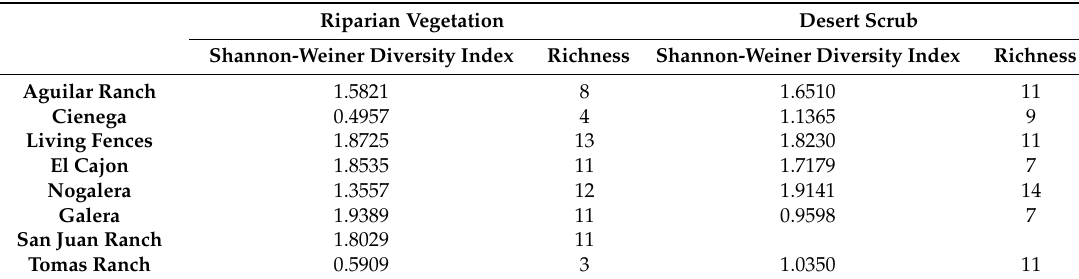
Table 8. Shannon-Weiner diversity index and richness values for Riparian Vegetation and Desert Scrub stands, for each site (shrubs and trees).